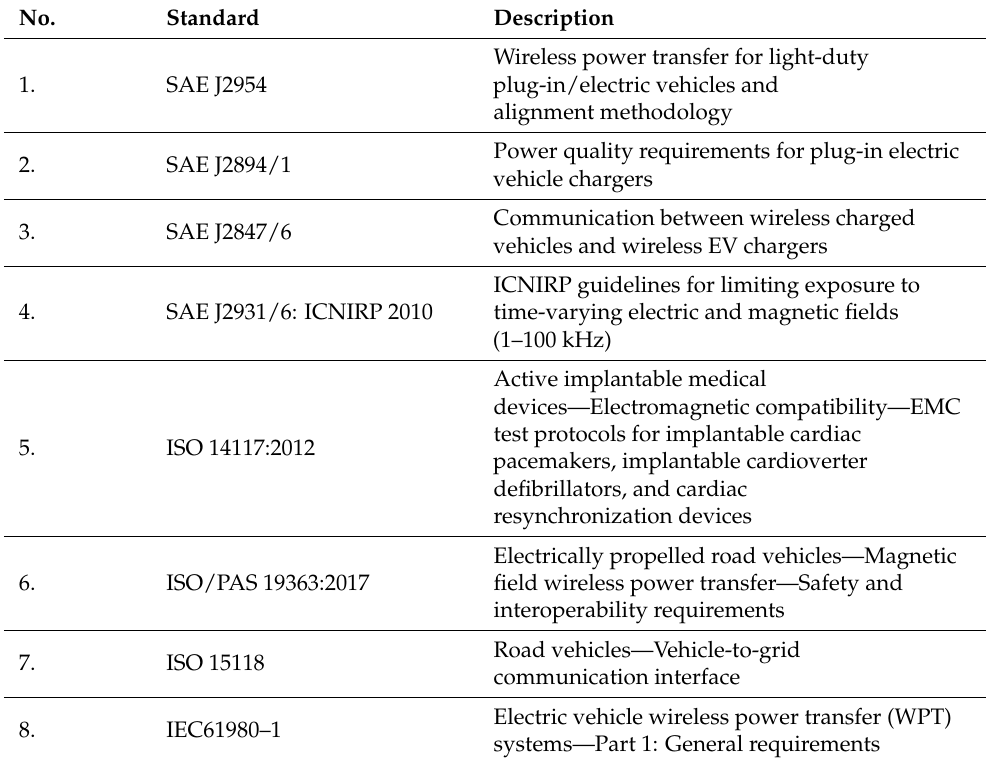
Table 3. WTP standards for electric vehicles